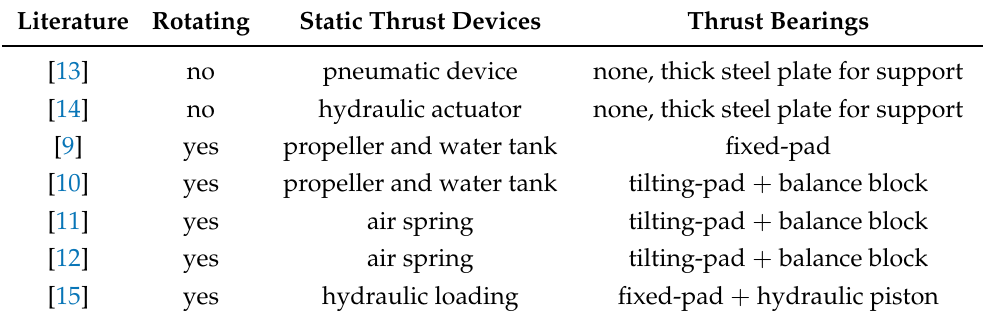
Table 1. Comparison of shafting system test